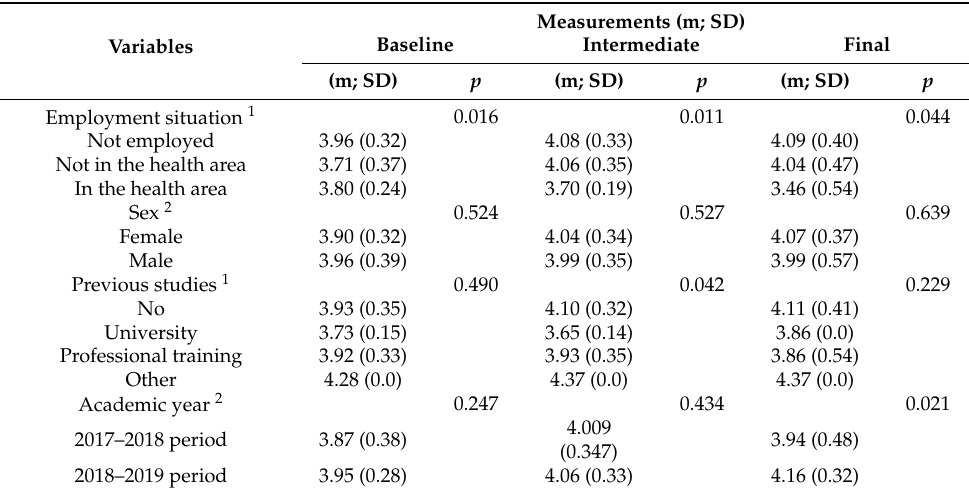
Table 3. Analysis of the global score of the questionnaire according to the sociodemographic variables ( N =